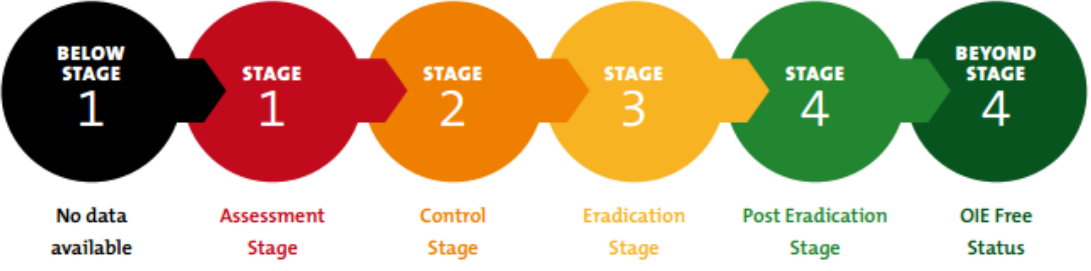
Figure 1. The four stages of the PPR GCES [1].